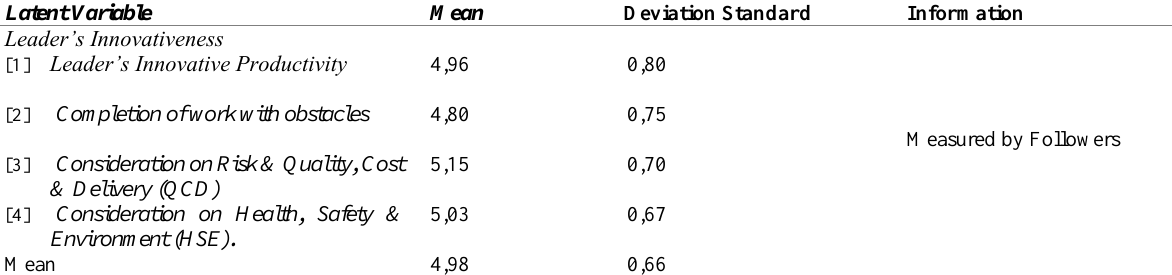
Table 3: Descriptive Statistics